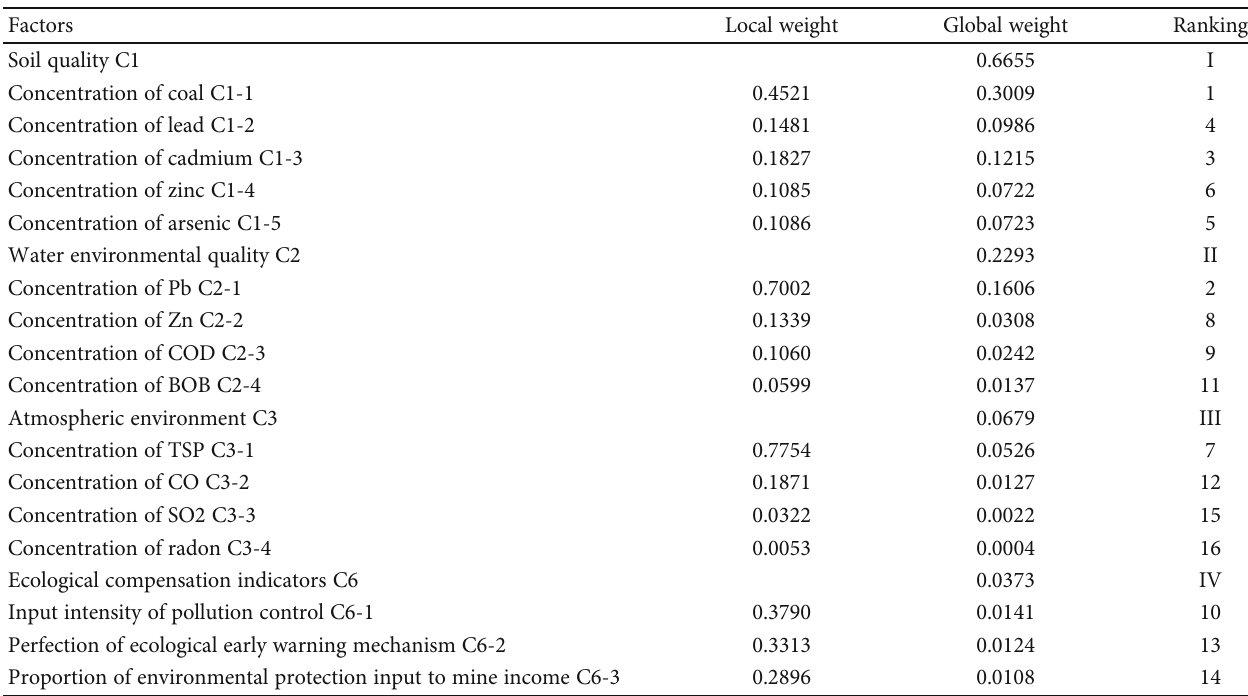
Table 11: The priorities of risk factors to the coal mine.